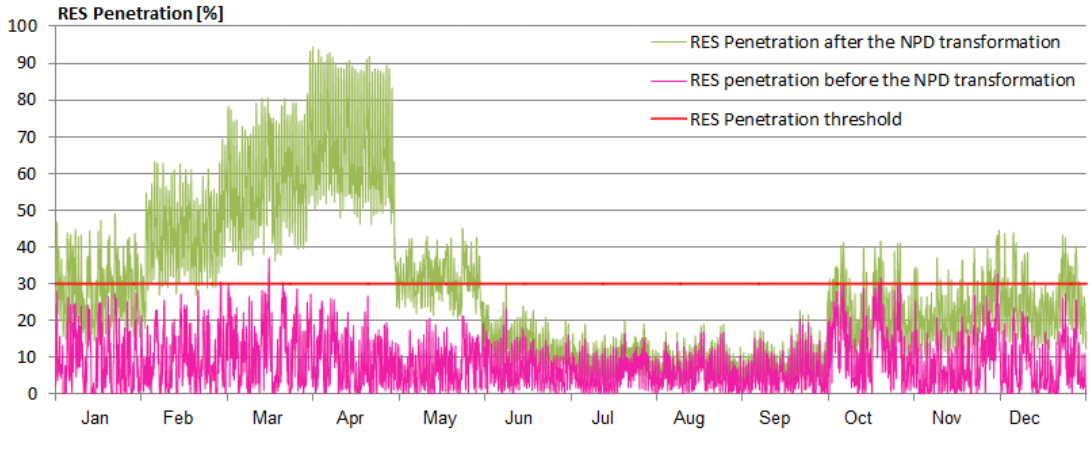
Figure 7. The penetration of RES with the hydro power